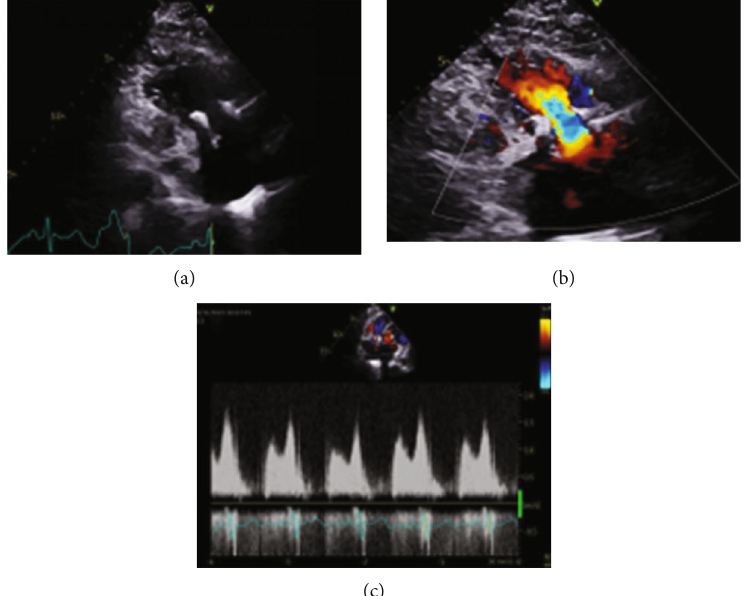
Figure 4: The transthoracic echocardiogram images during the 34-month follow-up period: TTE showed optimal valve position and well hemodynamic status (a, b). TTE with color fl ow showed a maximal velocity of 1.6m/s